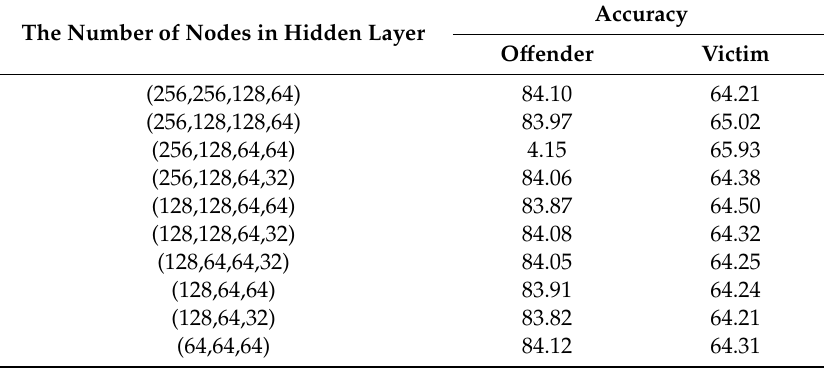
Table 6. O ff ender / Victim Injuries Accuracy by Hidden